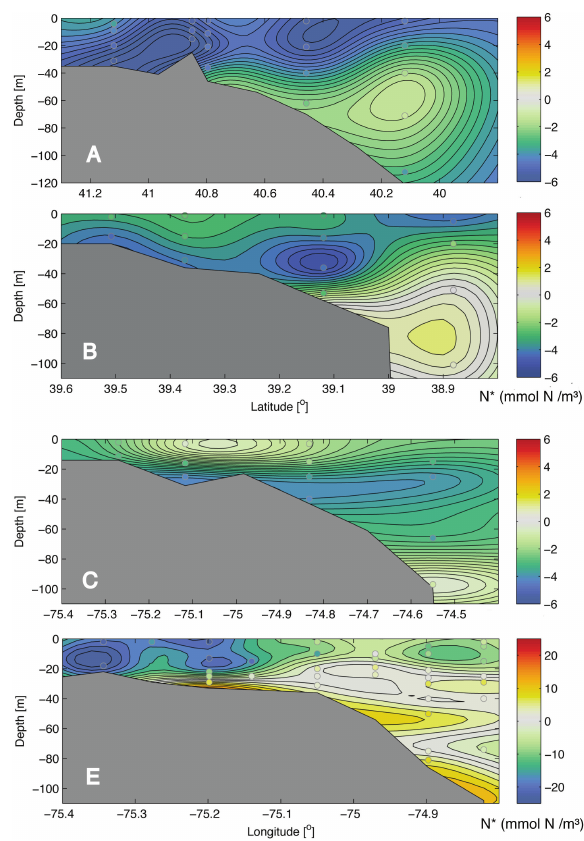
Fig. 5. N* along four transects on the MAB shelf (see Fig. 4 for station locations). The contour plots show optimally interpolated fields. The location of data points is shown by the colored circles; the color within circles indicates the observed value.